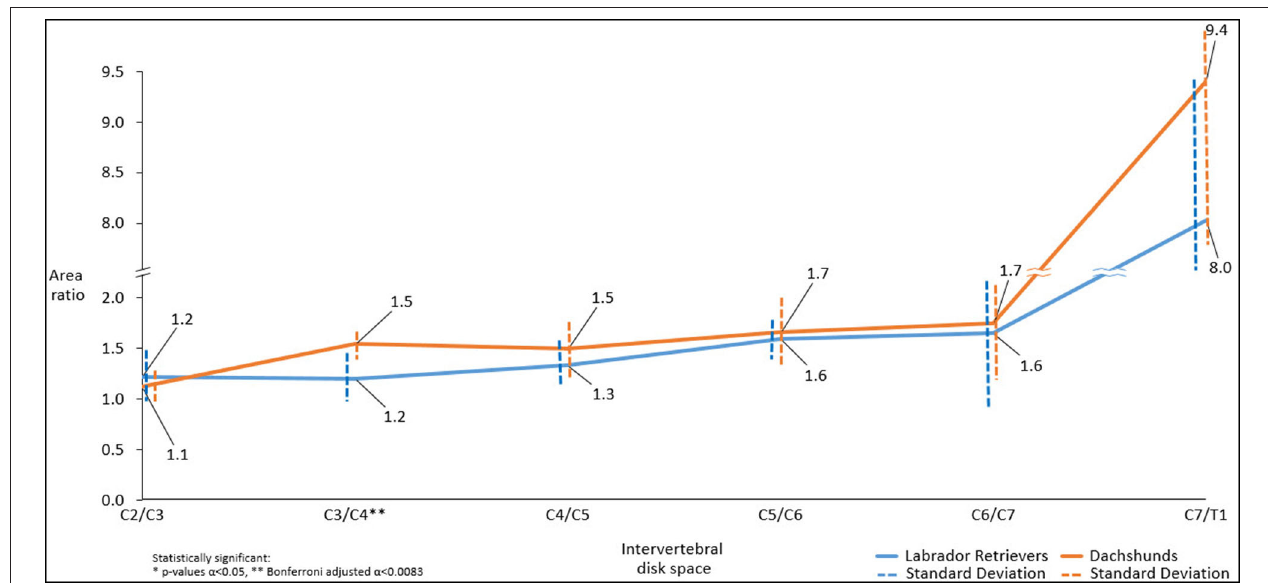
FIGURE 6 | Line graph showing mean dorsal-to-ventral paraspinal musculature area ratio along cervical spine of Dachshunds (orange) and Labrador Retrievers (blue) measured in transverse computed tomographic images. For accurate presentation, measurements pictured are rounded to one decimal place.